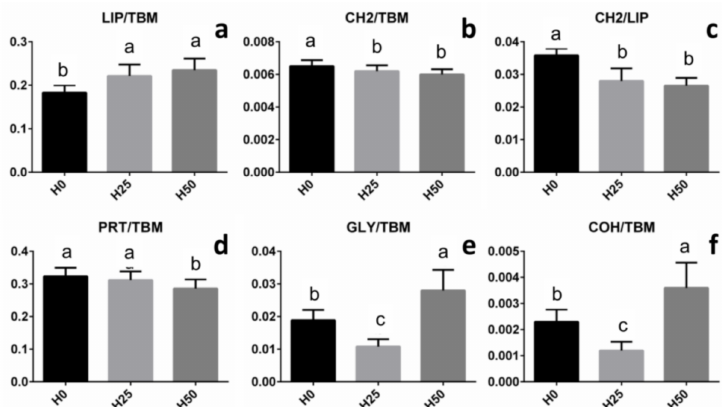
Figure 7. Statistical analysis of band area ratios calculated on H0, H25, and H50 liver samples: ( a ) LIP / TBM (total amount of lipids), ( b ) CH2 / TBM (total amount of saturated alkyl chains), ( c ) CH2 / LIP (saturated alkyl chains with respect to total lipids), ( d ) PRT / TBM (total amount of proteins), ( e ) GLY / TBM (total amount of glycogen), and ( f ) COH / TBM (total amount of carbohydrates). Values are presented as mean ± SD. Di ff erent letters indicate statistically significant di ff erences among the experimental groups ( p <